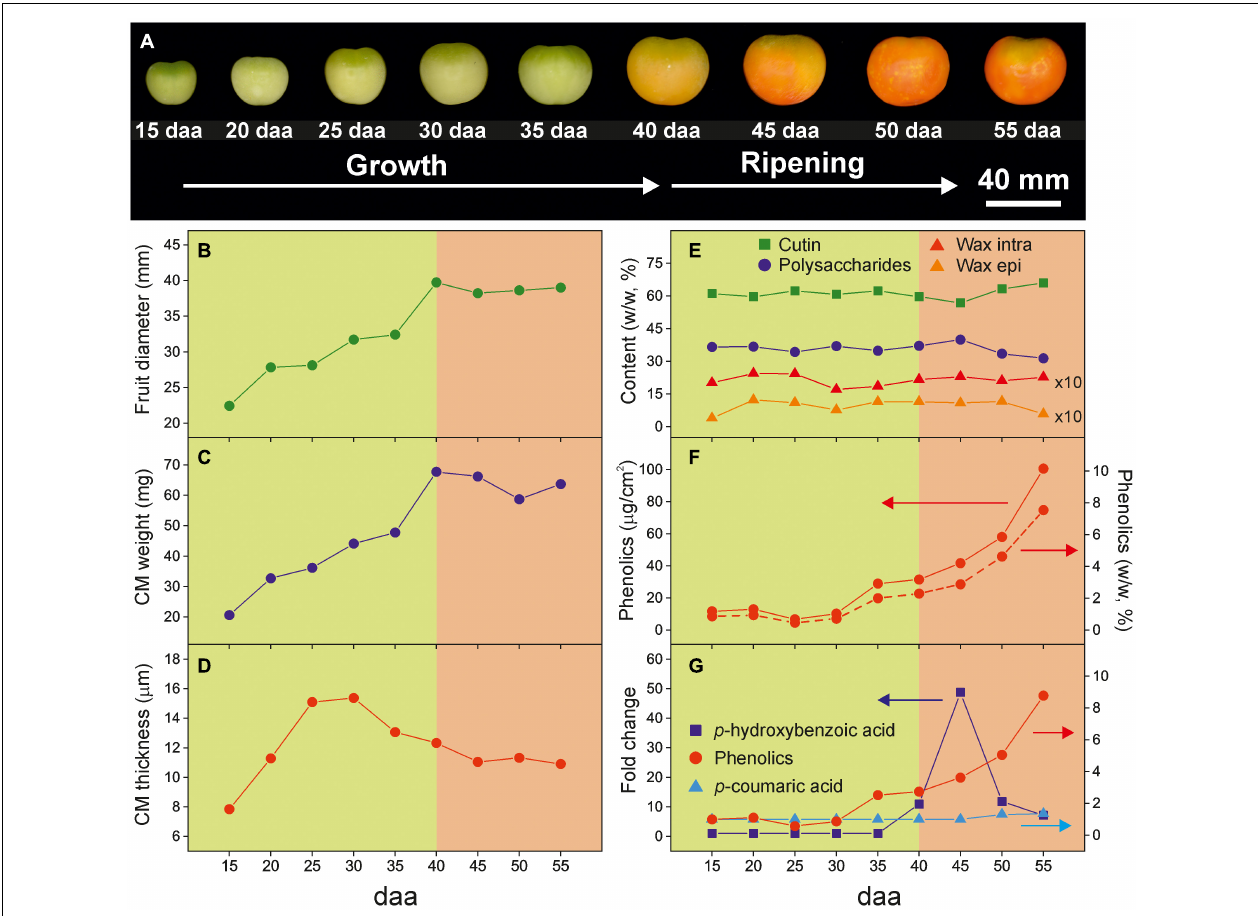
FIGURE 1 | (A) Visual aspect and parameters modification along tomato fruit growth and ripening [ (B) fruit diameter, (C) CM weight, (D) CM average thickness, (E) CM composition, (F) phenolics content and (G) relative evolution of hydroxycinnamic acids and total phenolic compounds in the cuticle membrane] (adapted from Domínguez et al., 2008 and España et al.,